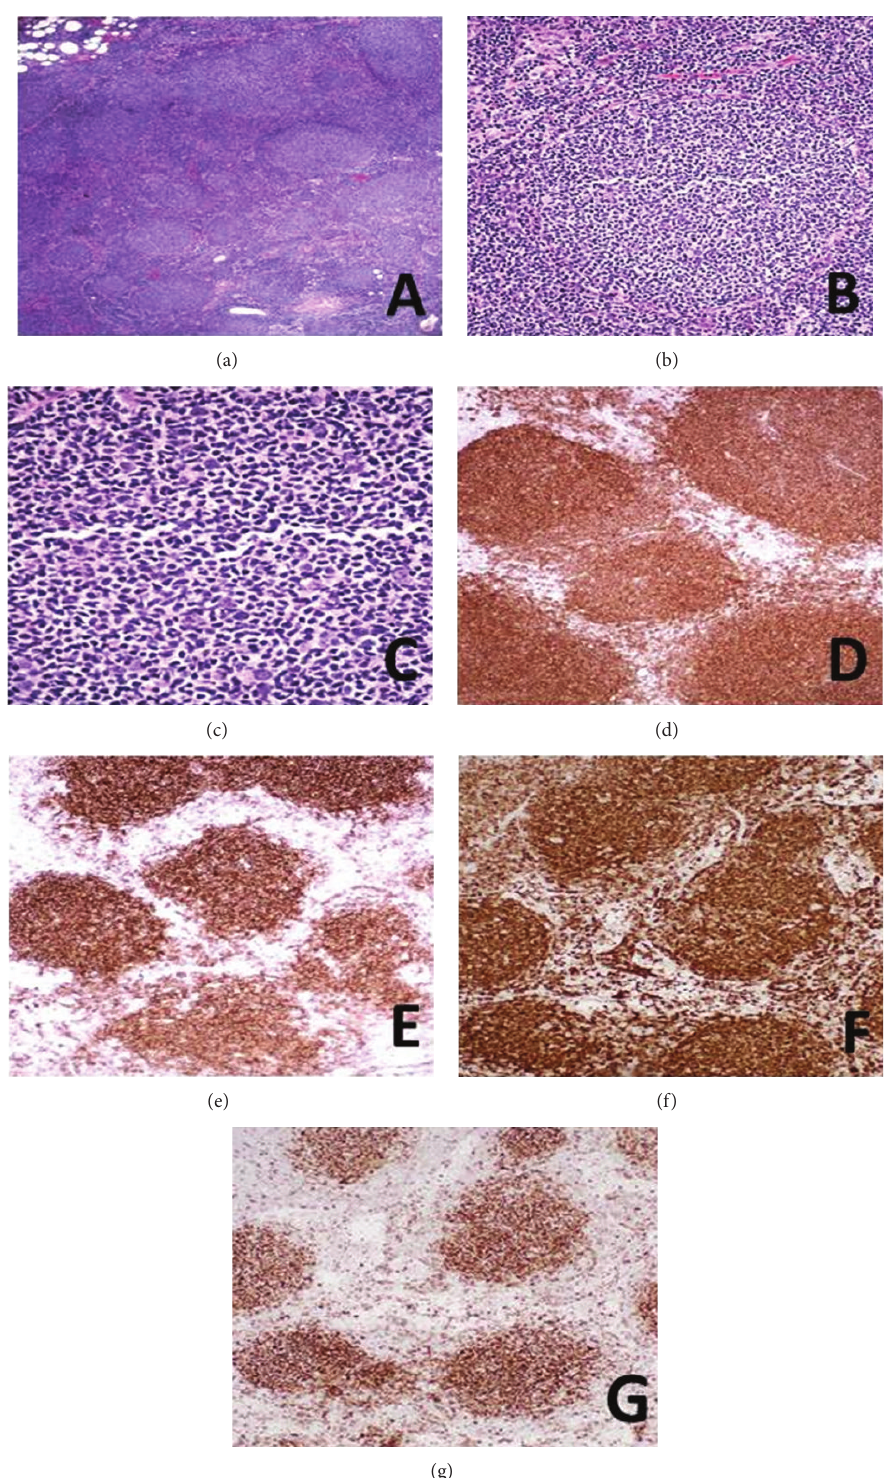
Figure 1: H & E and immunohistochemical staining of follicular components. Hematoxylin and eosin stained sections showed numerous neoplastic follicles occupying almost the entire lymph node, effacing the normal nodal architecture extending from the cortex to the hilum, and invading beyond the capsule ((a) 4x). The neoplastic follicles consist of small centrocytes with ovoid shape, small angulated nuclei, clumped chromatin, and inconspicuous or absent nucleoli. Rare intermixed centroblasts are seen ((b) 20x and (c) 40xs). Immunohistochemical staining revealed the germinal center cells expressing the pan B-cell marker CD20 ((d) 10x) in addition to germinal center-associated markers CD10 ((e) 10x), BCL-6 ((f) 10x), and BCL-2 ((g) 10x). The collective histologic and immunophenotype findings indicated a follicular lymphoma, grade 1 of